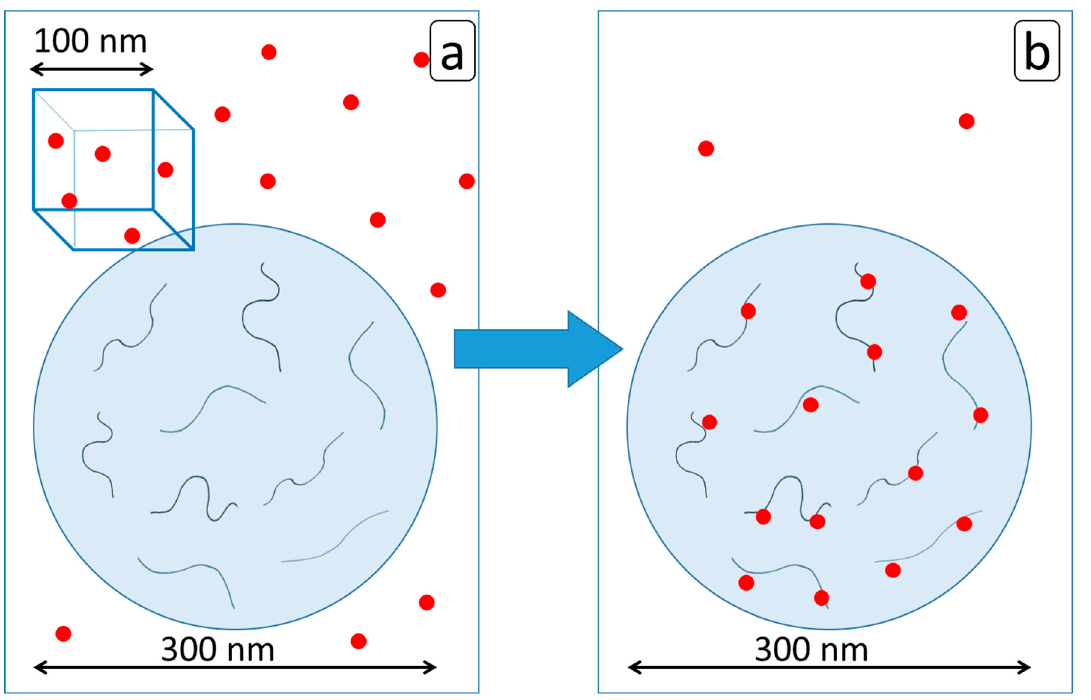
Figure 8. The proposed scheme of antiscalant efficacy due to sorption of solid impurities by aggregates of FAA-F1 molecules before ( a ) and after ( b ) the sorption takes place; red circles correspond to solids with the size of 1 nm, and blue ribbons correspond to PAA-F1 molecules (the size of solid impurities in the picture has been increased tenfold for better visibility, and the size of antiscalant has been increased three times).